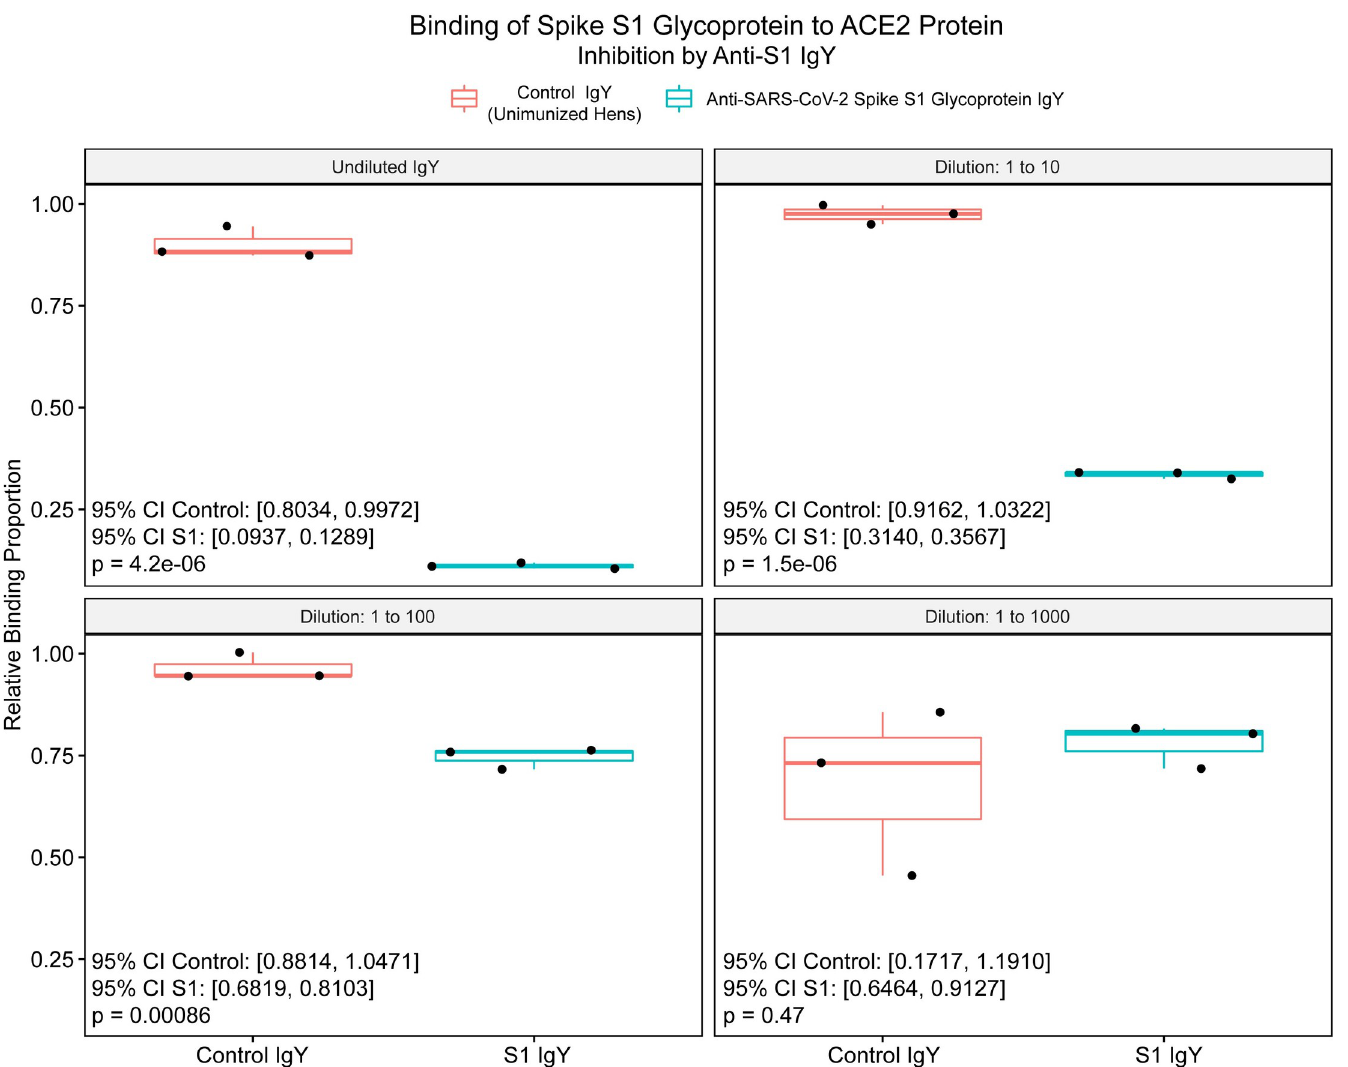
Fig 4. Box and whisker plots of SARS-CoV-2 spike glycoprotein (S1) percent binding to angiotensin converting enzyme-2 protein in a cell-free system. Relative binding proportion (Y-axis) was determined by the kit-provided standard binding inhibitor. Boxes represent interquartile range (IQR) with median shown as center bar of each sample group. Whiskers represent 1.5 times the IQR. P-value, by two-sample t-test method, and 95% confidence interval (CI) was calculated using R software package EnvStats (v.2.3.1) [19]. Undiluted (16.8 mg/ml), and logarithmic dilutions (1.68, 0.168, and 0.0168 mg/ml) are shown. Coral, control IgY, teal, anti-SARS-CoV- 2 spike glycoprotein